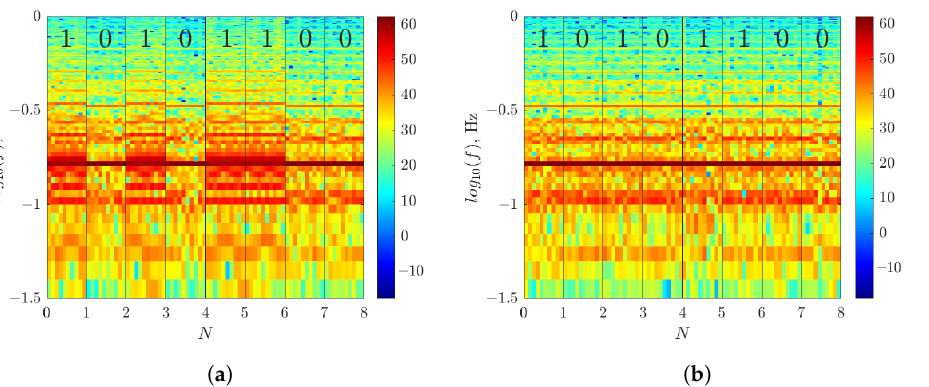
Figure 11. Spectrograms for message transmission using parameter modulation ( a ) and symmetry coefficient modulation ( b ). For parameter modulation, values a 1 = 0.2 and a 2 = 0.22 were switched while values of b = 0.2 and c = 5.7 were constant. For SCM case, symmetry coefficients were S 1 = 0.4 and S 2 = 0.6,